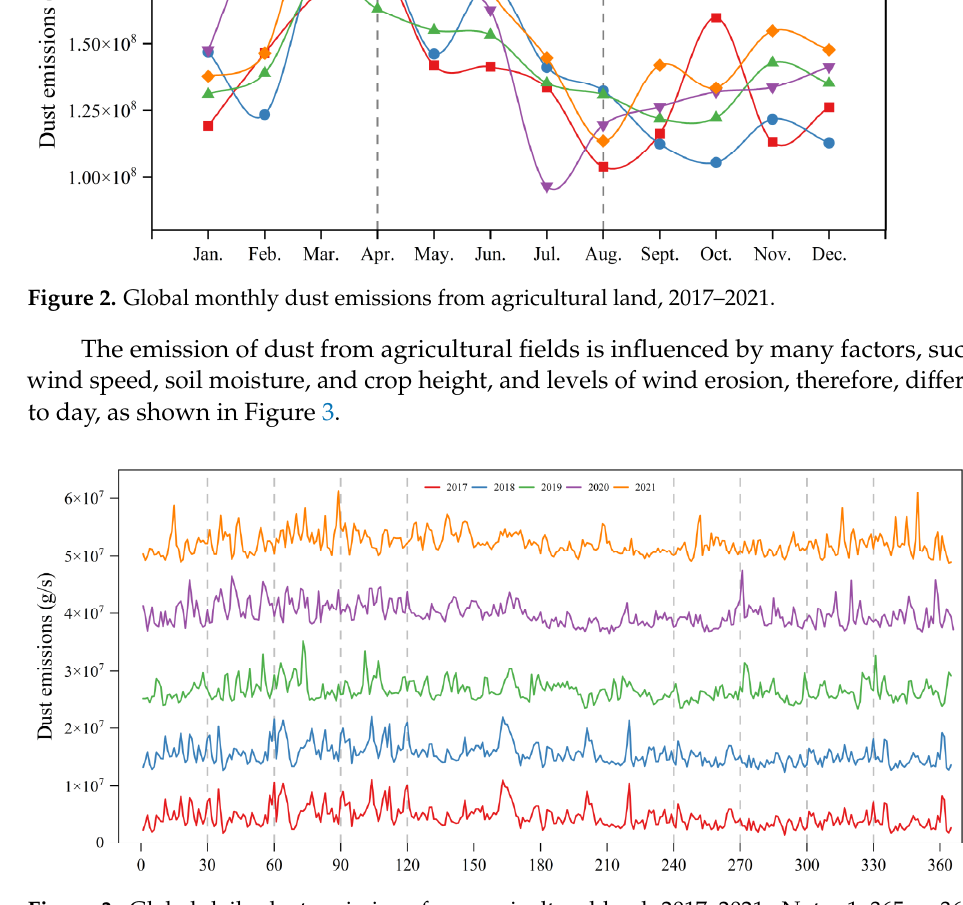
Figure 2. Global monthly dust emissions from agricultural land, 2017–2021.